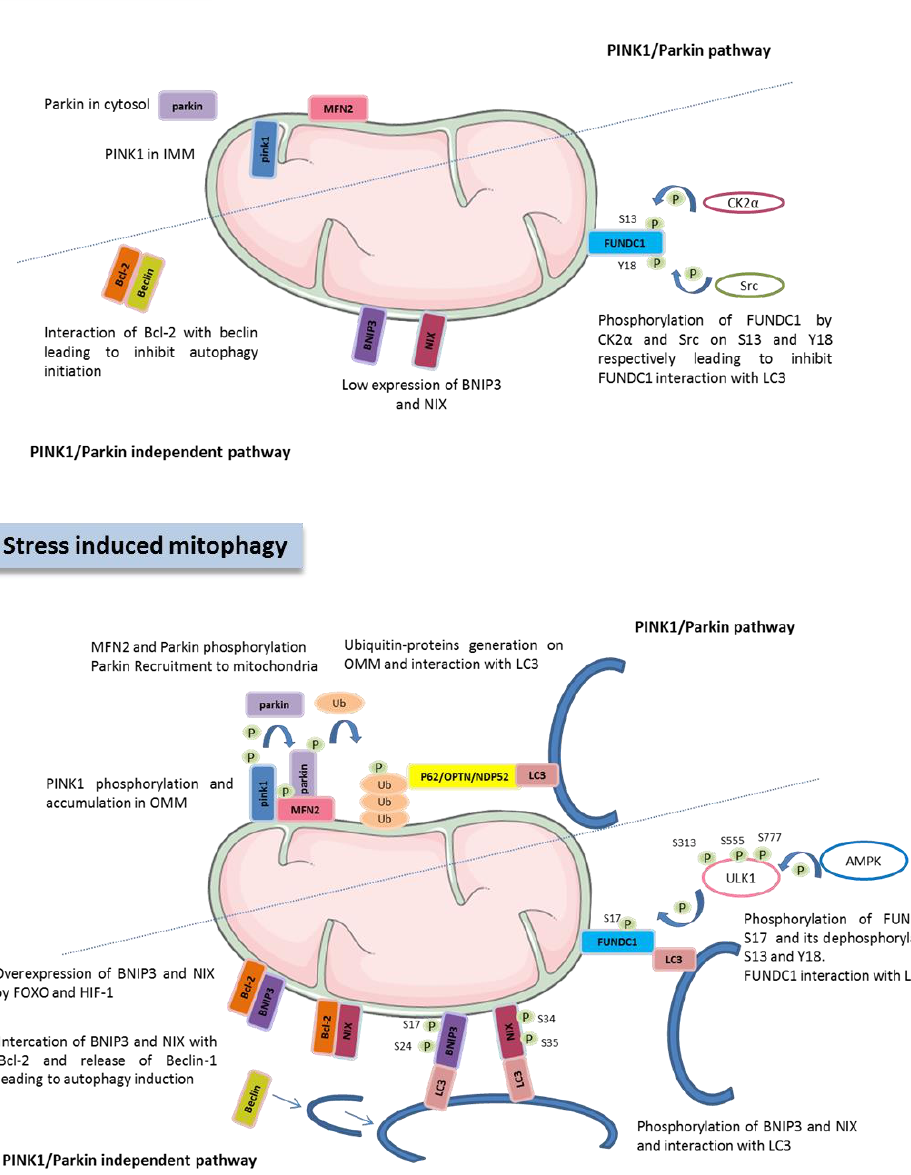
Figure 1. Pathways involved in mitophagy regulation. Mitophagy can be regulated by the following three independent pathways: PINK1/parkin-mediated mitophagy, FUNDC1-mediated mitophagy and BNIP3/NIX-mediated mitophagy. The localization, the post-translational modifications and the interactions of the proteins involved in these pathways in normal and under stress-mediated mi- tophagy conditions are summarized. PINK1: PTEN-induced putative kinase protein-1, MNF2: mi- tofusin-2, BNIP3: Bcl2 interacting protein 3, FOXO: Forkhead Box O, HIF1α : hypoxia-inducible fac- tor 1-alpha, FUNDC1: FUN14 domain-containing 1, ub: ubiquitin, P: phosphorylation, S: serine, Y: